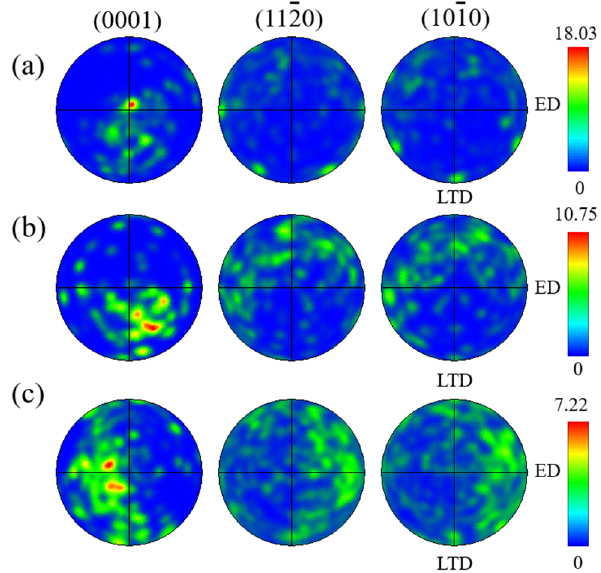
Figure 8. Pole figures of ( a ) WQ (20 °C) ( b ) WQ (100 °C) ( c ) AC.